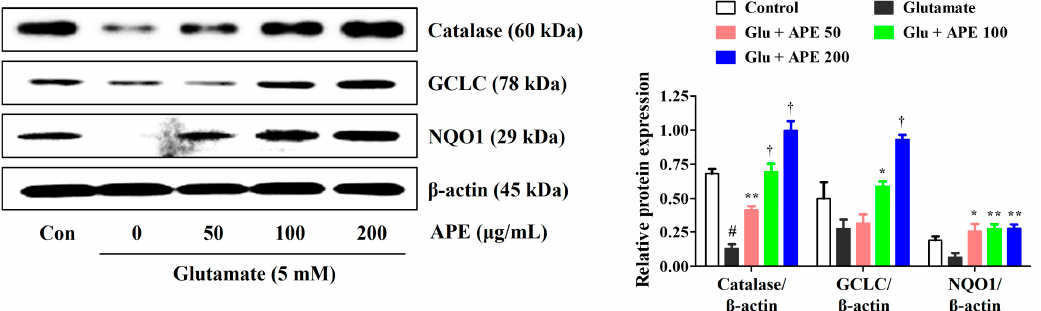
Figure 5. Effects of Arecae Pericarpium ethanol extract on the activation of antioxidant enzymes in glutamate-exposed HT22 cells. The cells were incubated with 5 mM glutamate with or without APE . The expression levels of catalase, GCLC subunits, and NQO1 were determined via Western blot analysis. Control was non-treated cells. Blot images represent the three independent experiments. Data were presented as mean ± standard error of the mean. Statistical significance was set at # p < 0.05 (vs. control), * p < 0.05, ** p < 0.01, and † p < 0.001 (vs. glutamate). APE, Arecae Pericarpium